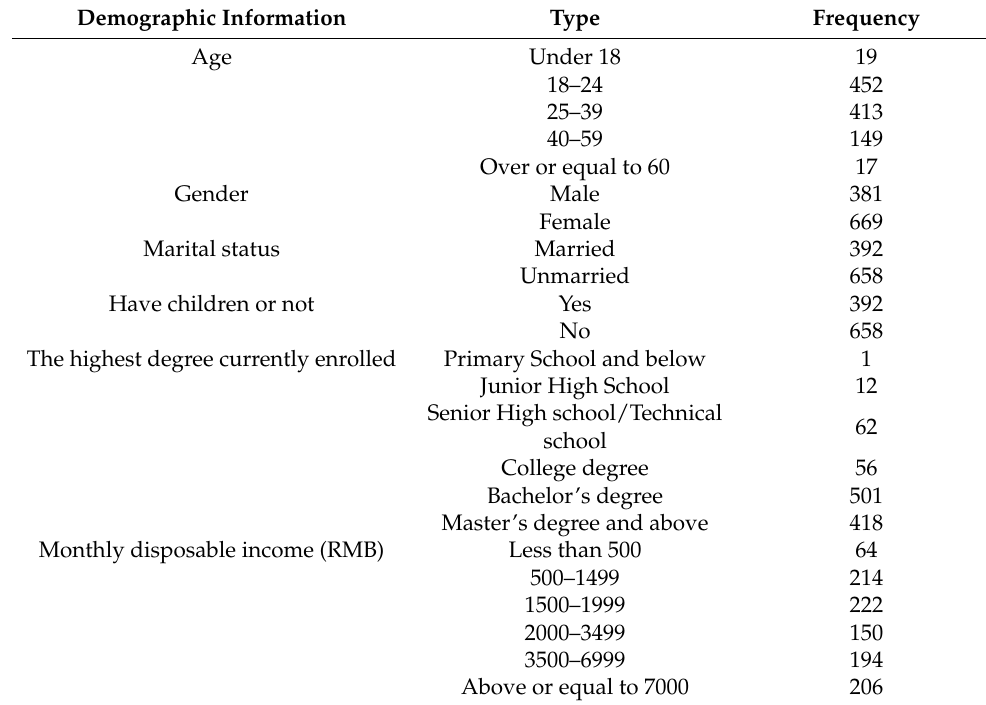
Table 1. Demographic information of respondents in the questionnaire ( n =